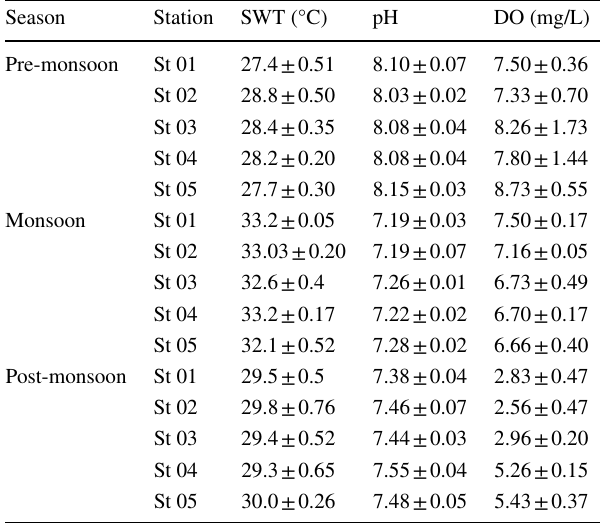
Table 1 Mean values of environmental parameters in different season at